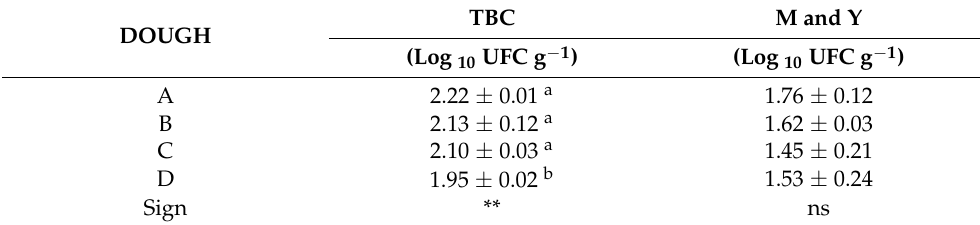
Table 5. Total bacterial count (TBC) and mold (M) and yeast (Y) growth values for doughs.